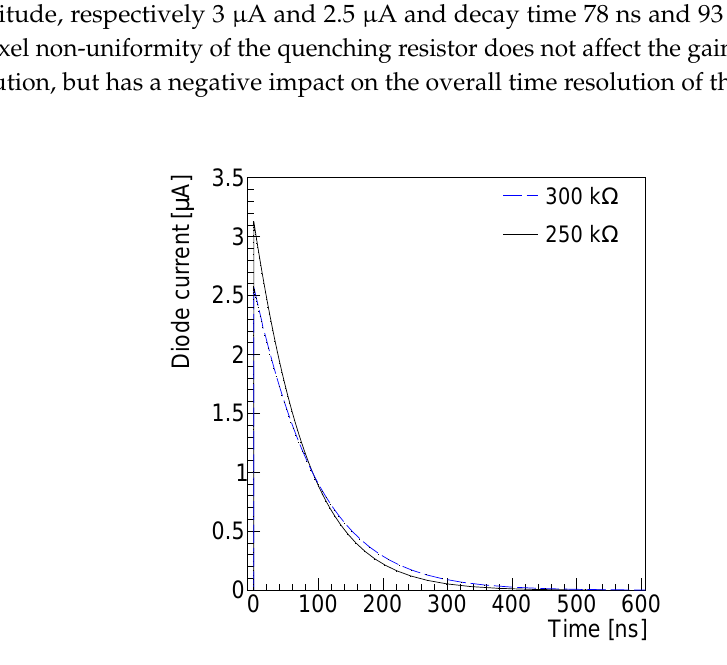
Figure 7. Simulated current of a SiPM sensor in response to a single photon or a thermally produced electron/hole pair for 250 k Ω (black continuous line) and 300 k Ω (blue dotted line) quenching